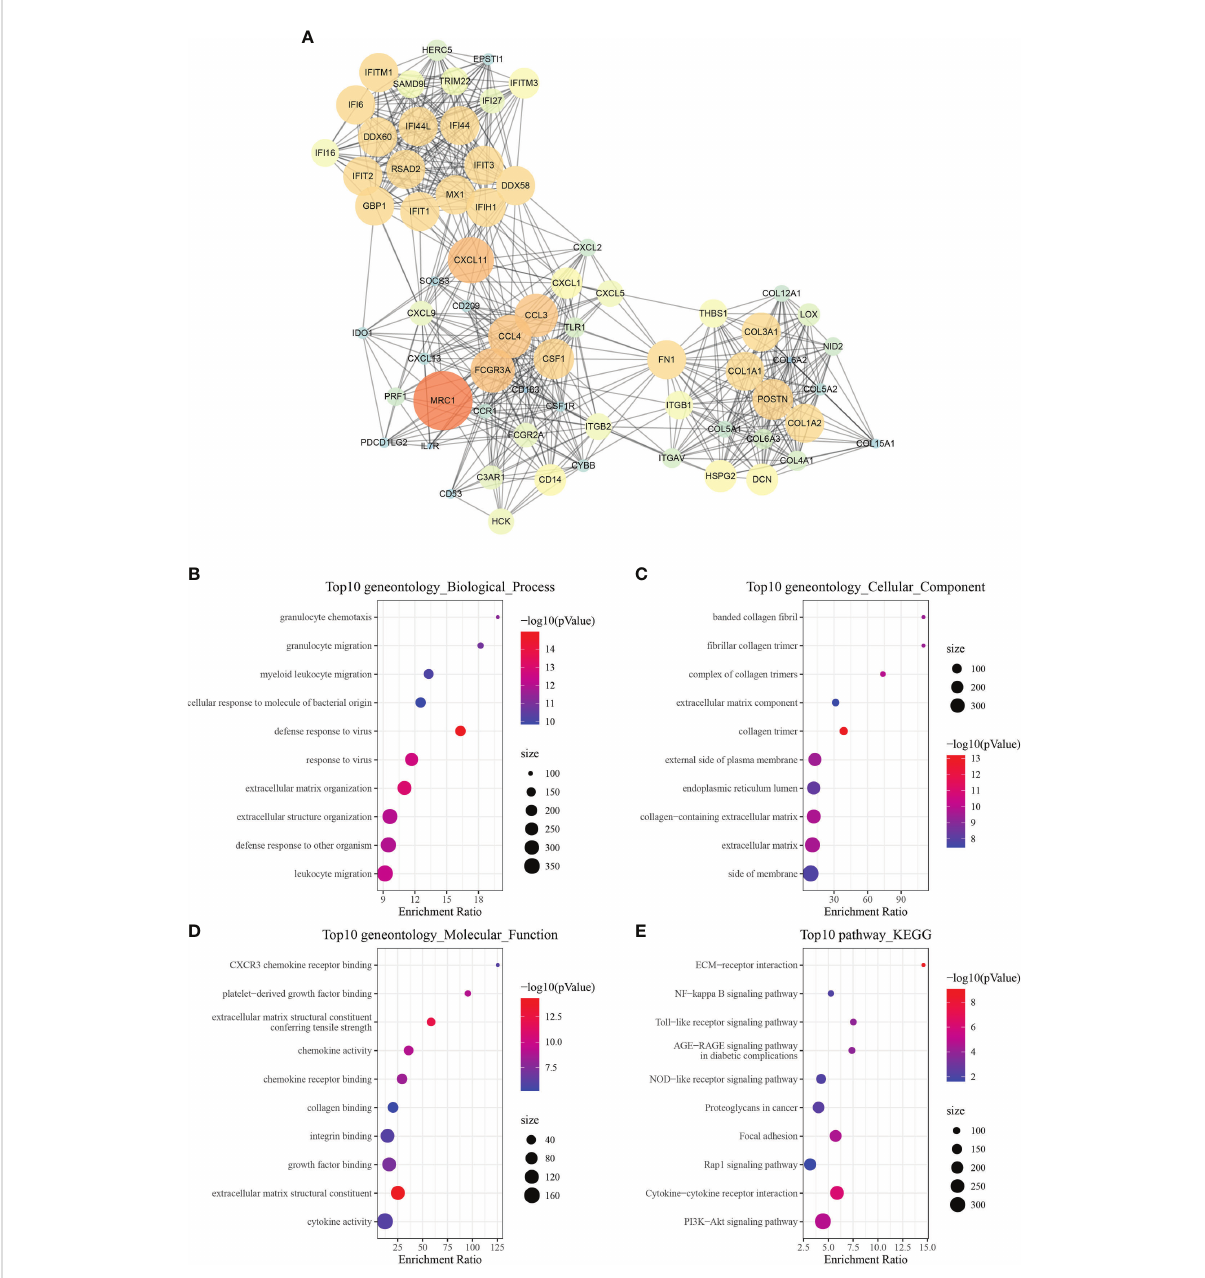
FIGURE 8 Module function analysis. (A) PPI analysis diagram of module Mcode1 (the larger the circle is, the darker the color is, the greater the score of mcodes representing genes is, and the more important the genes are). (B – E) GO and KEGG functional enrichment analysis of the gene of module